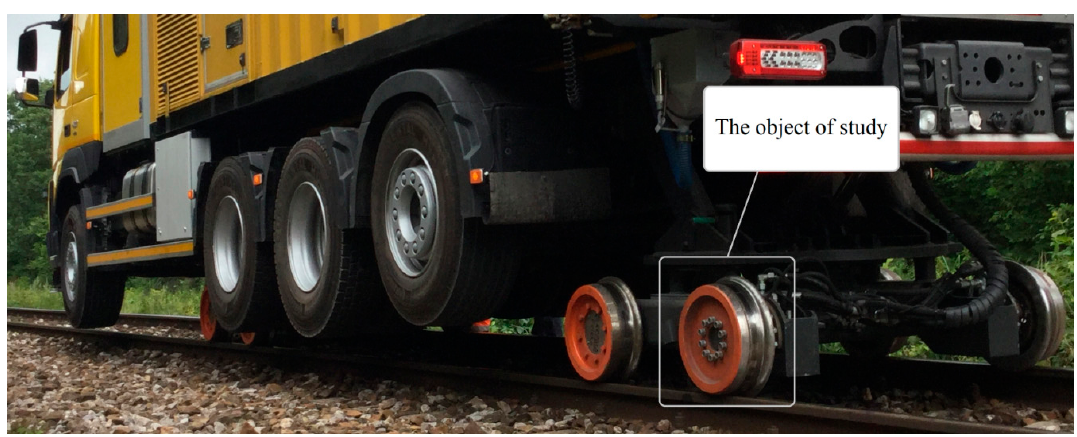
Figure 1. Road-rail vehicle with hydraulic driven rail system.